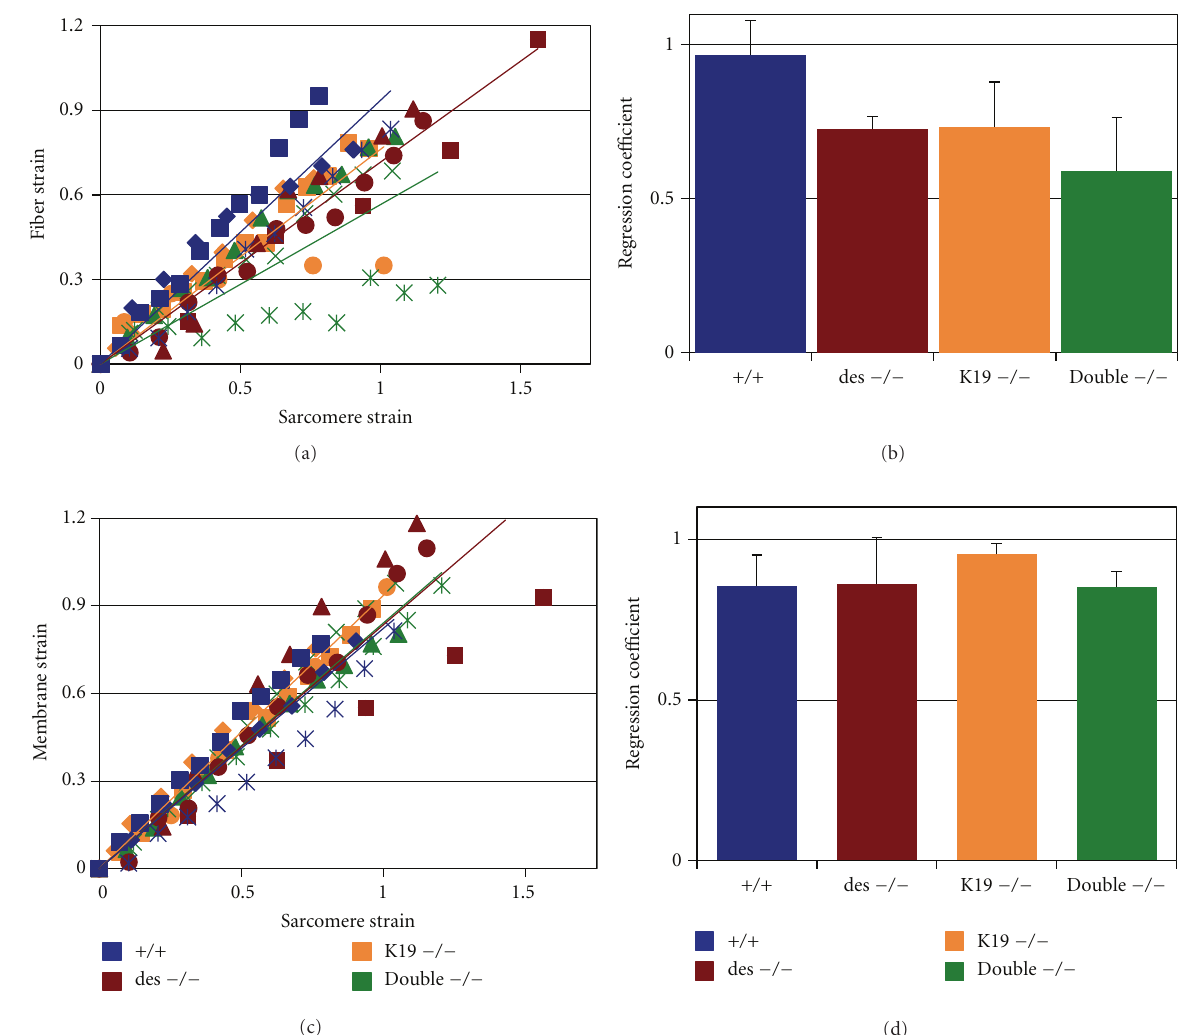
Figure 3: Relationships between global fiber strain and local membrane and sarcomere strain. Raw data (a, c) and regression coe ffi cients (b, d) for (a-b) fiber strain-sarcomere strain; (c-d) membrane strain-sarcomere strain for fibers from 10-month-old wild-type (blue), desmin- null (red), K19-null (orange), and double-null (green) animals ( n = 3 fibers/genotype). Di ff erent symbols within a color group represent data from individual experiments. Displayed regression lines in (a) and (c) represent averaged coe ffi cients for individual experiments reported in (b) and